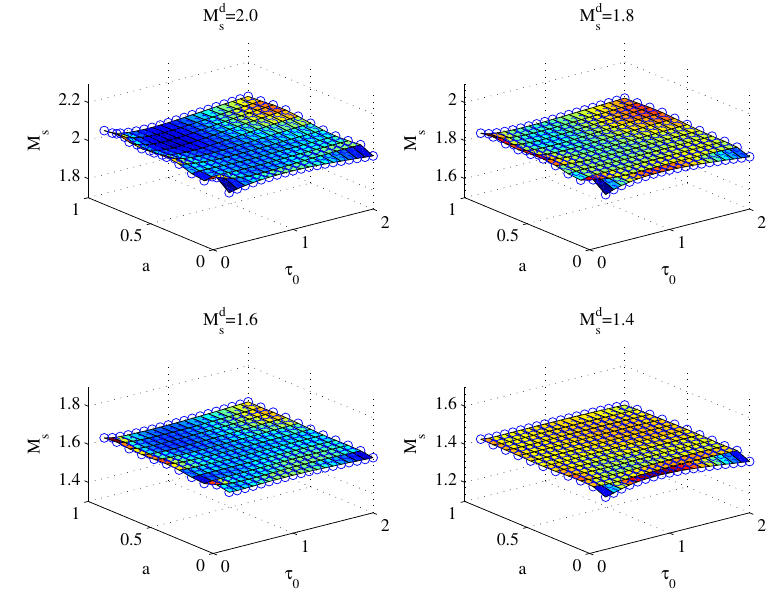
Figure 4. M s in the servo